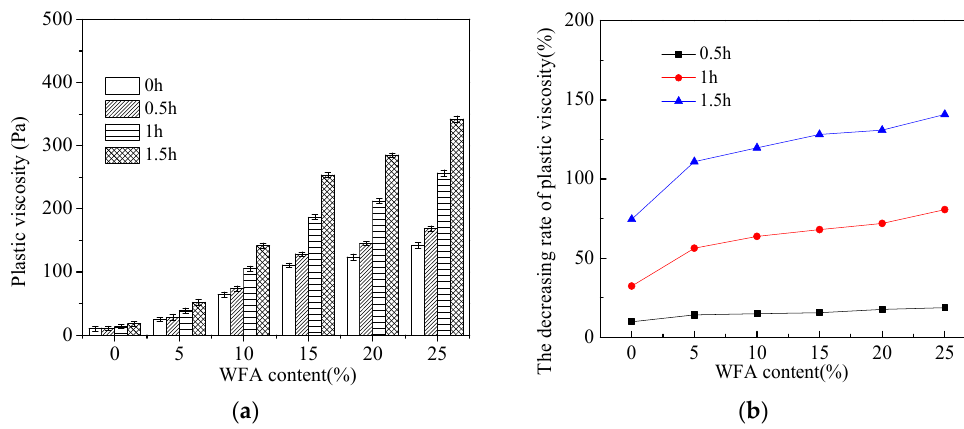
Figure 4. The plastic viscosity of fresh cement paste with different dosages of waste fly ash. ( a ) The plastic viscosity of fresh paste, ( b ) the decreasing rate of plastic viscosity.